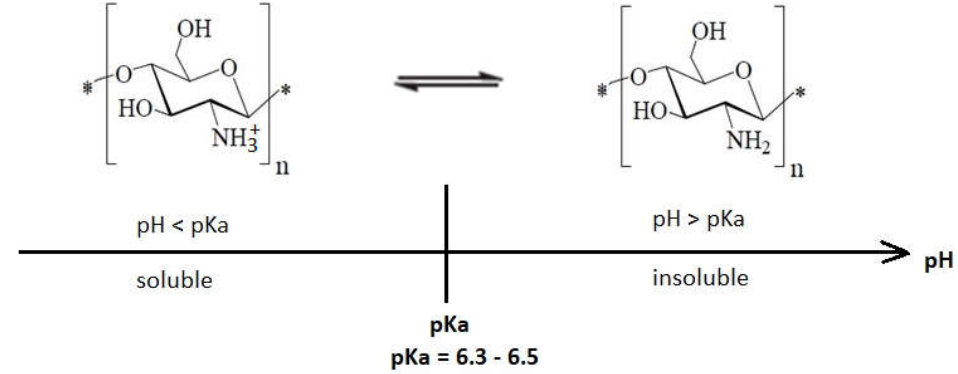
Figure 6. The pH influence upon chitosan solubility according to [57].